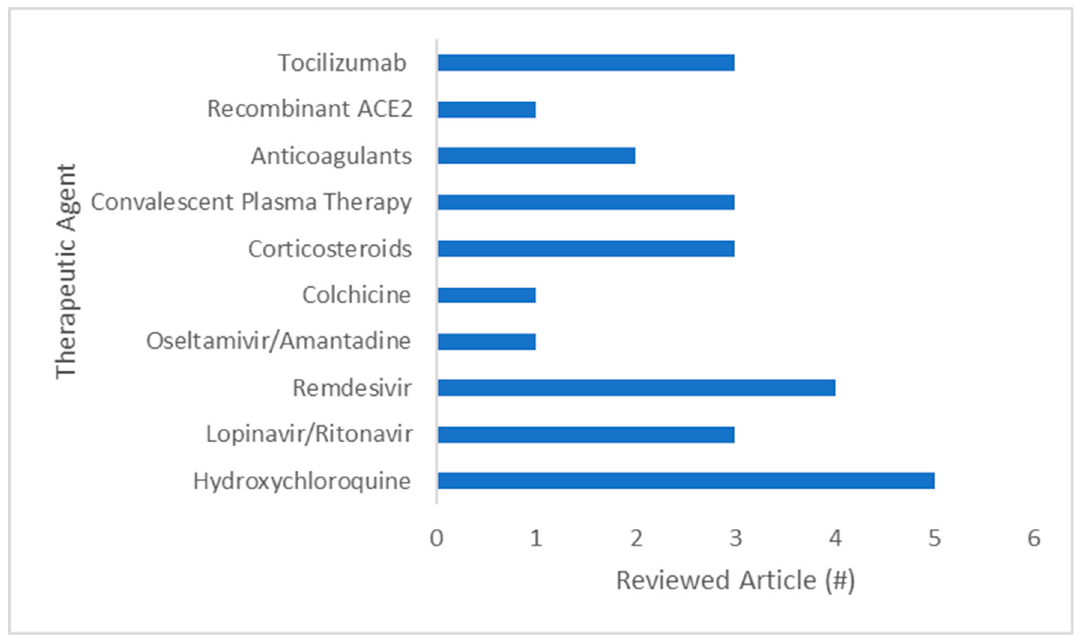
Figure 1. Number of publications reviewed in this review.